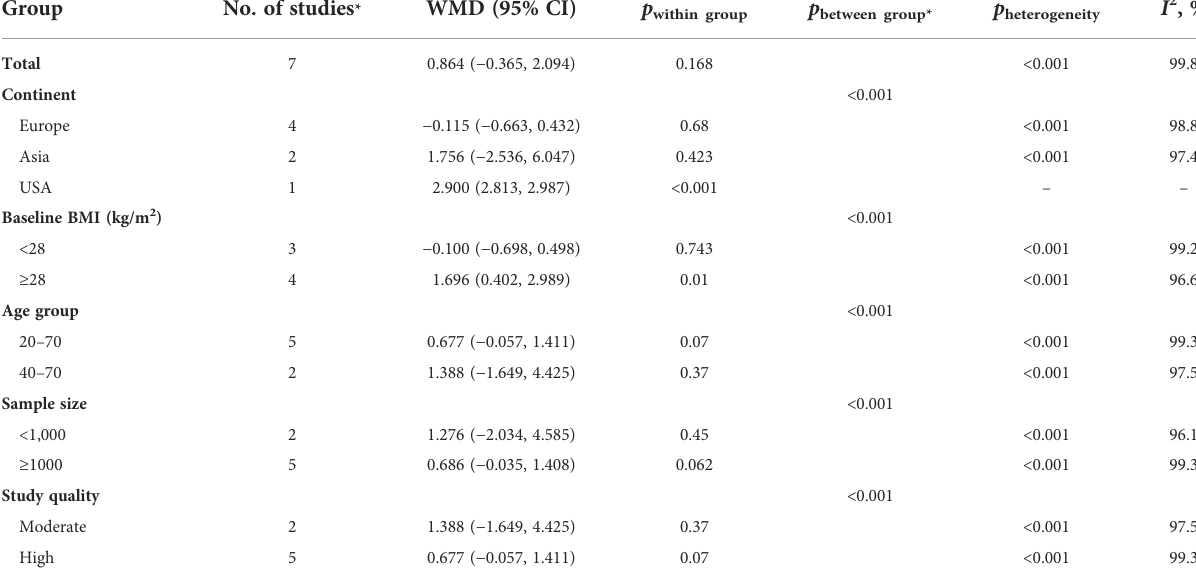
TABLE 6 Subgroup analysis for the comparison of BMI between highest versus lowest dietary AGE.